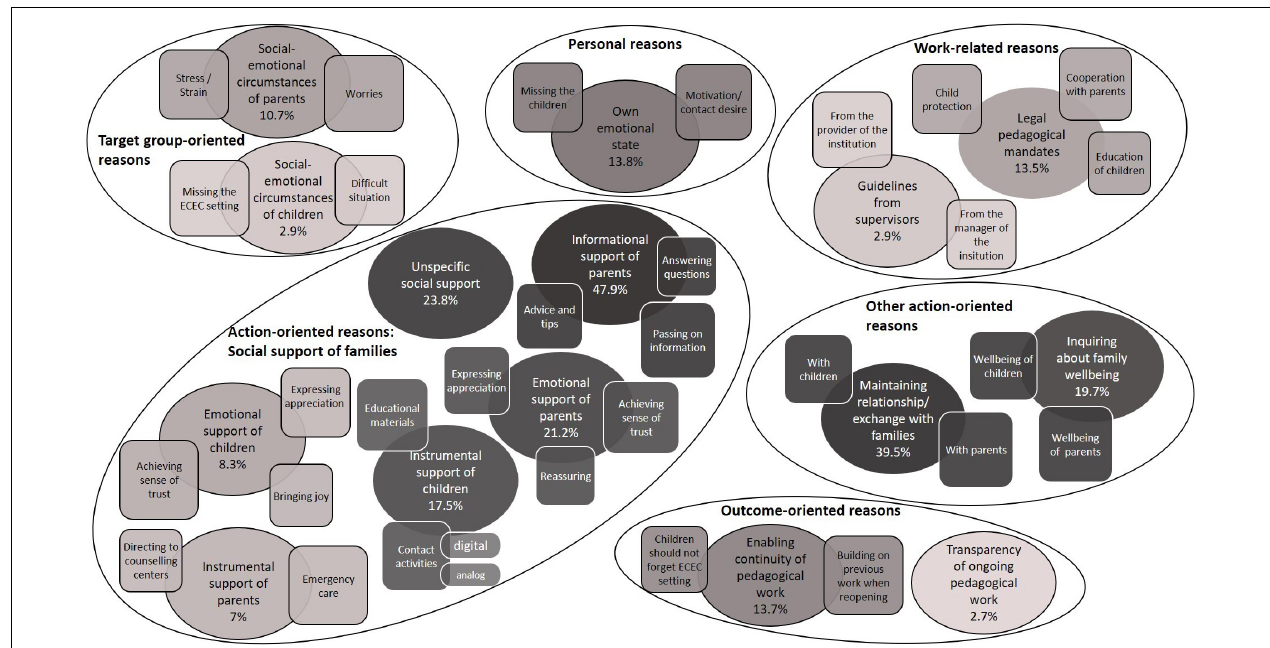
FIGURE 1 | ECEC professionals’ reasons for being in contact with parents. The categories are divided, based on comprehensive thematic dimensions, with large circles. Inside each large circle, the main categories are shown as circles, while subcategories are illustrated as squares. The categories change from dark to light according to the frequency of the assigned